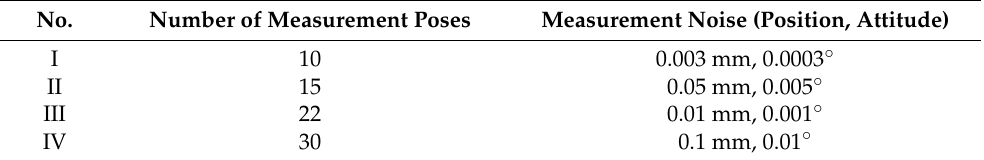
Table 3. Four measurement conditions in the numerical simulation of the kinematic calibration. No. Number of Measurement Poses Measurement Noise (Position,